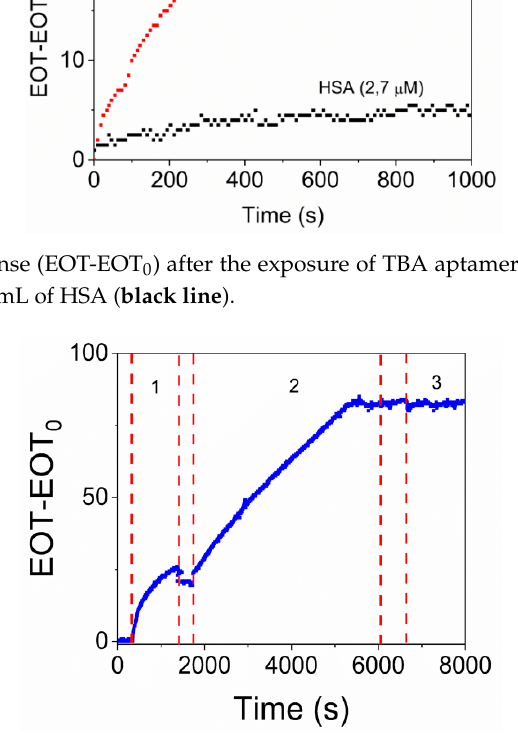
Figure 6. Optical response (EOT-EOT 0 ) after the exposure of TBA aptamer to 1.35 µM of thrombin ( red line ) and to 2.7 µg/mL of HSA ( black line ).